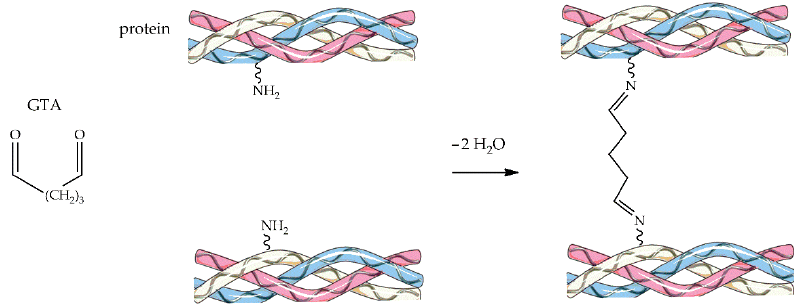
Figure 4. Schematic representation of the GTA-crosslinking